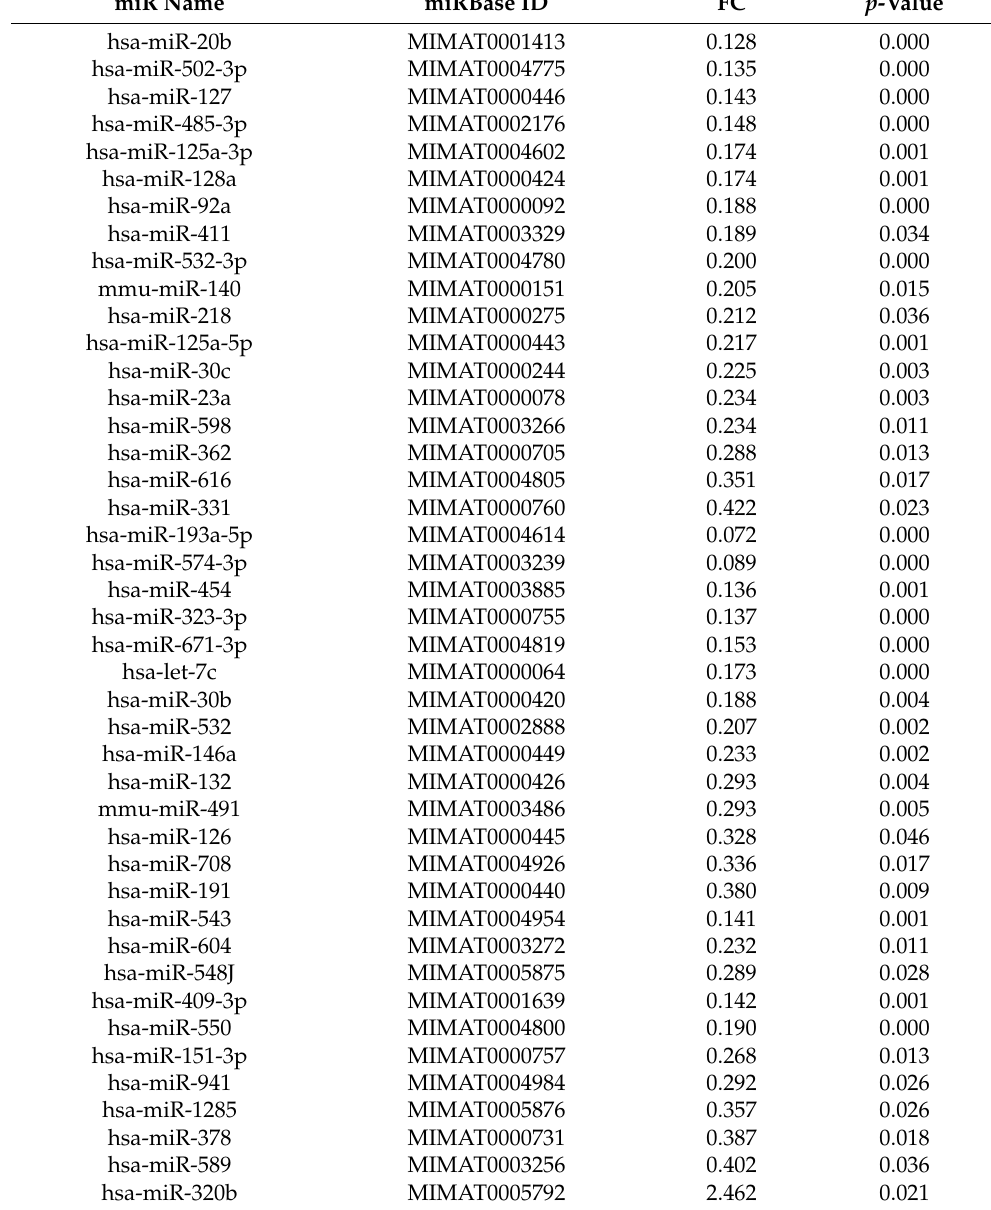
Table 1. Differentially expressed